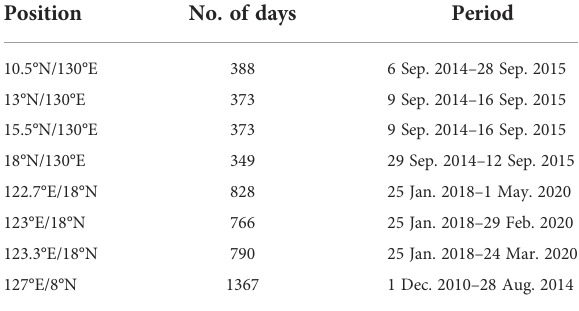
TABLE 1 Positions, total days, and corresponding periods for the ADCPs during mooring